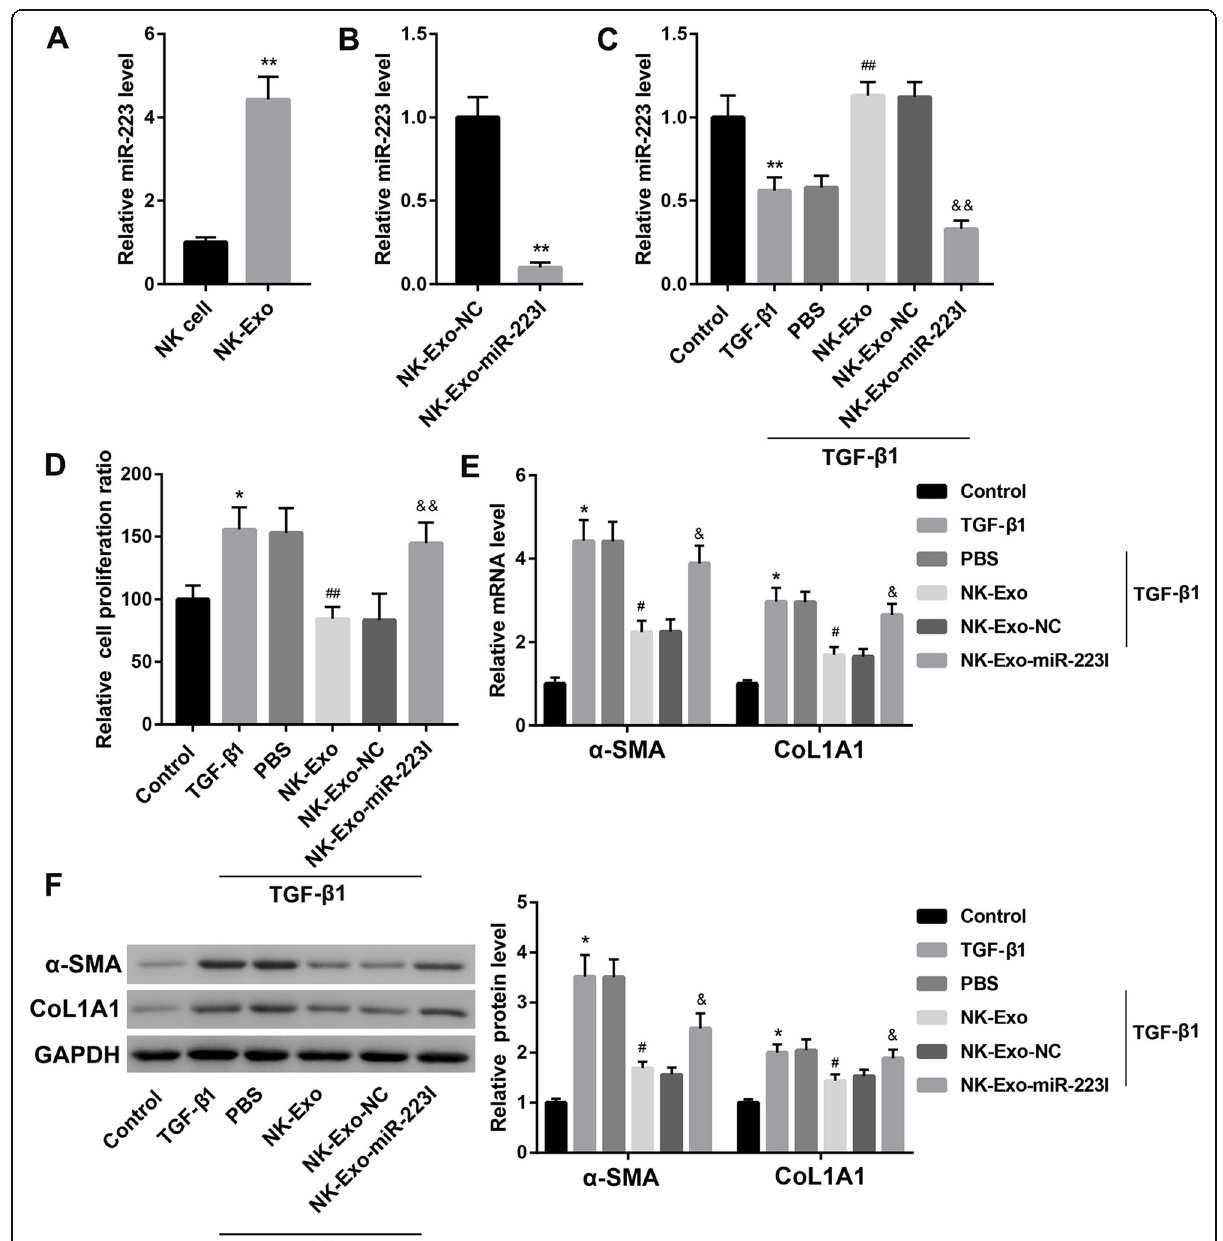
Fig. 1 NK-Exo attenuated TGF- β 1-induced HSC activation by transferring miR-223. a The relative expression of miR-223 determined by qRT-PCR in NK-92MI cells and NK-92MI cell-derived exosomes (NK-Exo). ** P < 0.01 vs. NK cell. b The relative expression of miR-223 determined by qRT-PCR in exosomes derived from NK-92MI cells transfected with inhibitor NC (NK-Exo-NC) or miR-223 inhibitor (NK-Exo-miR-223I). ** P < 0.01 vs. NK-Exo-NC. The relative expression of miR-223 determined by qRT-PCR (c) , cell proliferation ratio determined by CCK-8 assay (d) , the mRNA (e) and protein (f) levels of α -SMA and CoL1A1 in LX-2 cells in the groups of Control, TGF- β 1, TGF- β 1 + PBS, TGF- β 1 + NK-Exo, TGF- β 1 + NK-Exo-NC, and TGF- β 1 + NK-Exo-miR-223I. * P < 0.05, ** P < 0.01 vs. Control; # P < 0.05, ## P < 0.01 vs. TGF- β 1 + PBS; & P < 0.05, && P < 0.01 vs. TGF- β 1 + NK-Exo-NC. The data are presented as the mean ± standard deviation ( n =